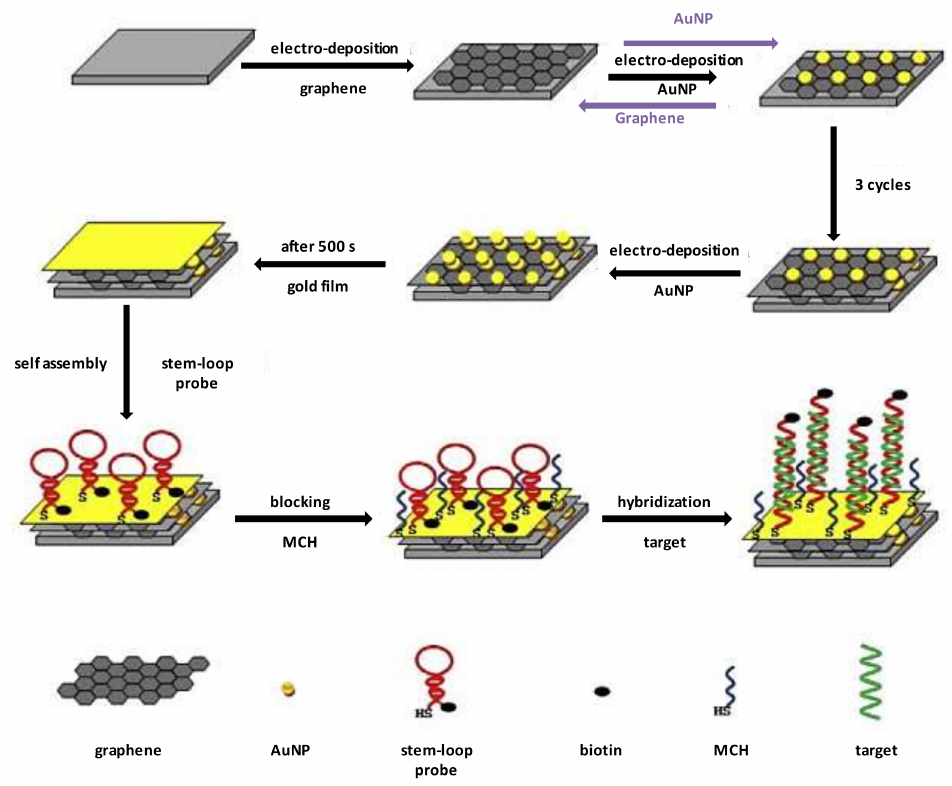
Figure 3. Schematic illustration of the fabrication of the electrochemical stem-loop DNA biosensor. Reprinted with permission from [68]. Copyright 2012 American Chemical